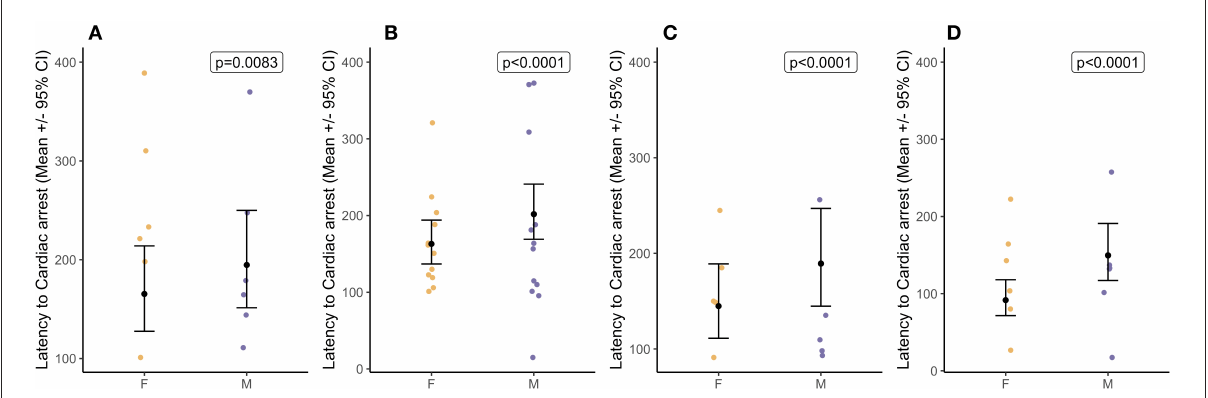
FIGURE7 Sex differences (mean ± 95% CIs) in latency to cardiac arrest for each target decompression cycle rates: (A) 40 ms − 1 ( n = 12), (B) 60 ms − 1 ( n = 24), (C) 80 ms − 1 ( n = 10), and (D) 100 ms − 1 ( n =